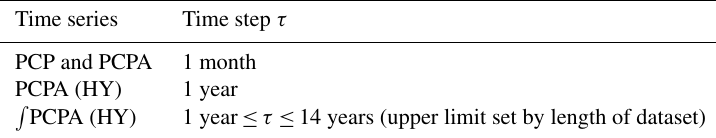
Table 2. The time step τ for each of the precipitation time series investigated in the